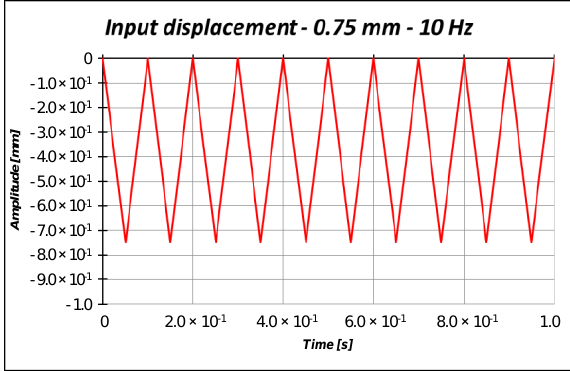
Figure 12. Input triangular displacement.